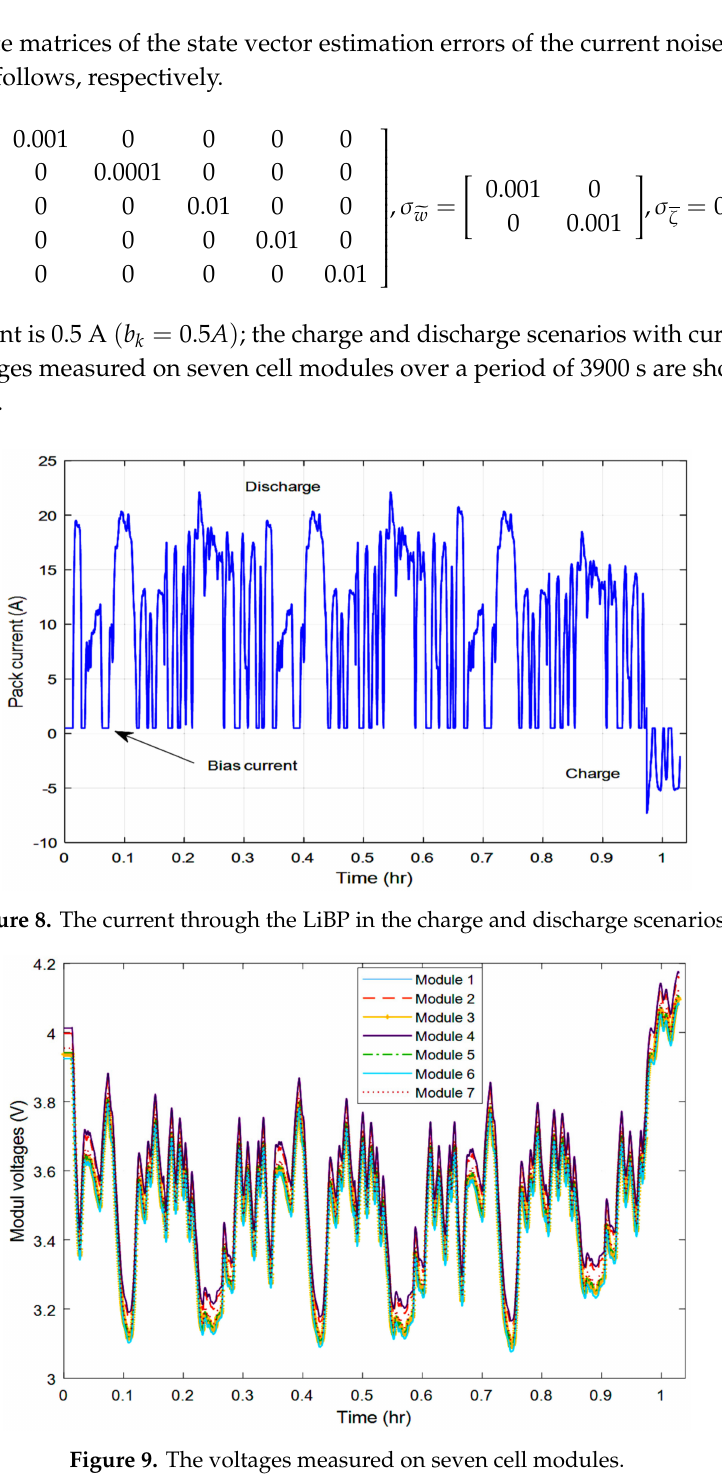
Figure 9. The voltages measured on seven cell